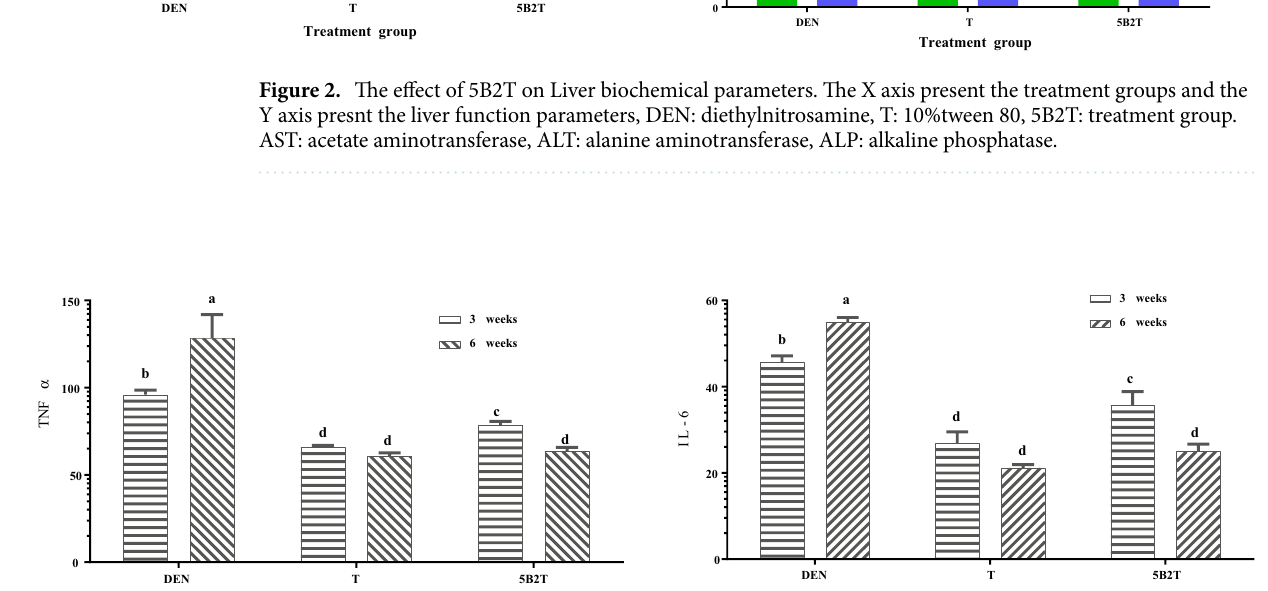
Figure 3. The effect of 5B2T on the Pro-inflammatory cytokines TNF-α and IL-6 levels. The X axis present the treatment groups and the Y axis presnt the cytokines levels, DEN: diethylnitrosamine, T: 10%tween 80, 5B2T: treatment group. TNFα: tumor necrosis factor alpha and IL-6: Interleukin